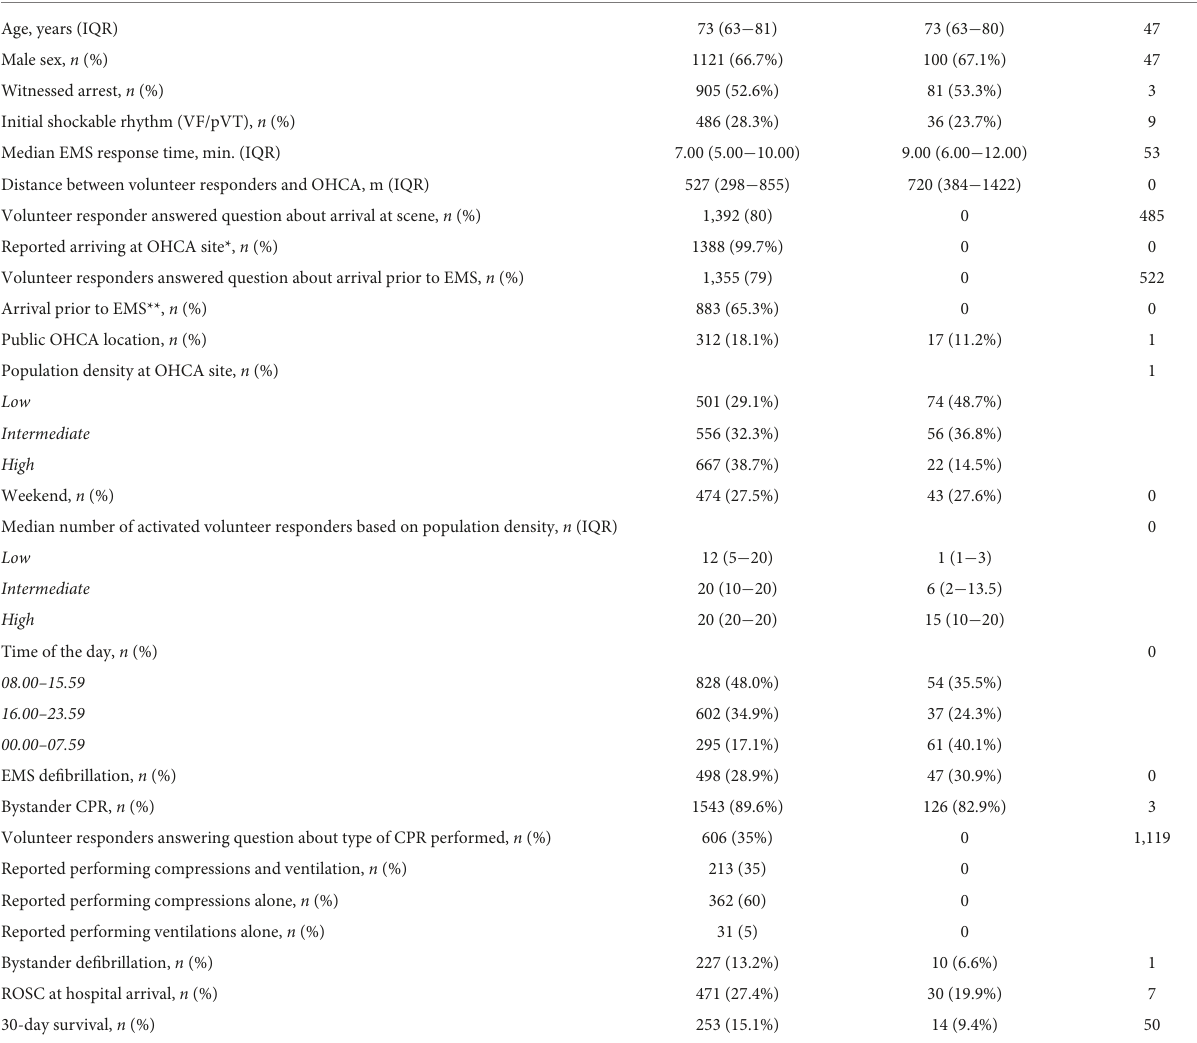
TABLE 1 Characteristics of population with out-of-hospital cardiac arrest and volunteer responder activation based on accept or no accept of